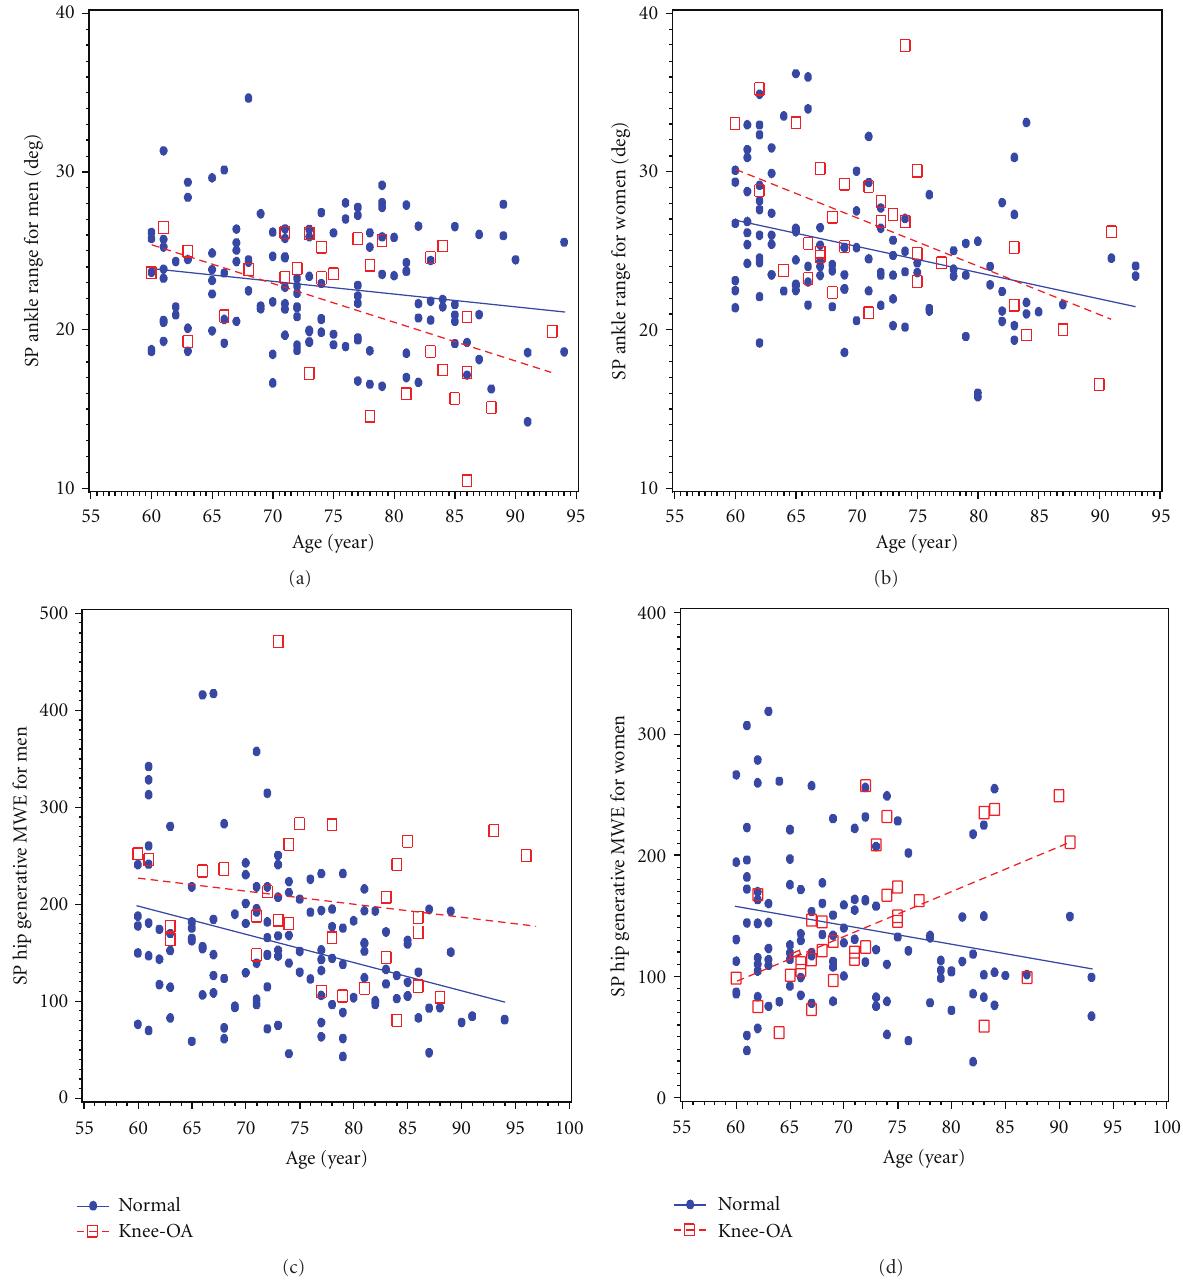
Figure 1: Ankle range of motion in the sagittal plane (SP) for men (a) and women (b) with and without knee-OA by year of age. Hip generative mechanical work expenditure (MWE; J/kg ∗ 1000) in the sagittal plane (SP) for men (c) and women (d) with and without knee- OA by year of